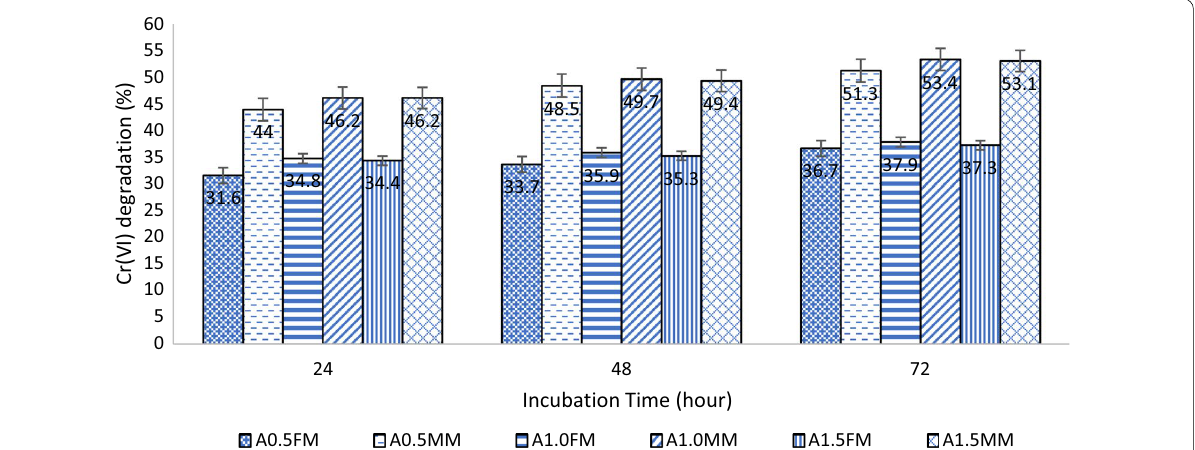
Fig. 2 Comparing chromium(VI) reducing the efficiency of fresh media (FM) and modified media (MM) with different aeration (A) rates (0.5, 1.0 and 1.5 vvm) and at a constant agitation speed of 150